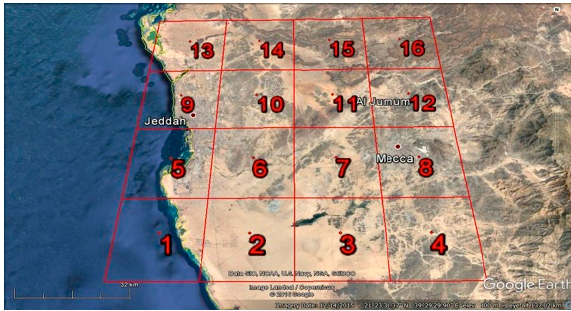
Figure 3. Coverage of TRMM 3B42RT pixels over Jeddah.